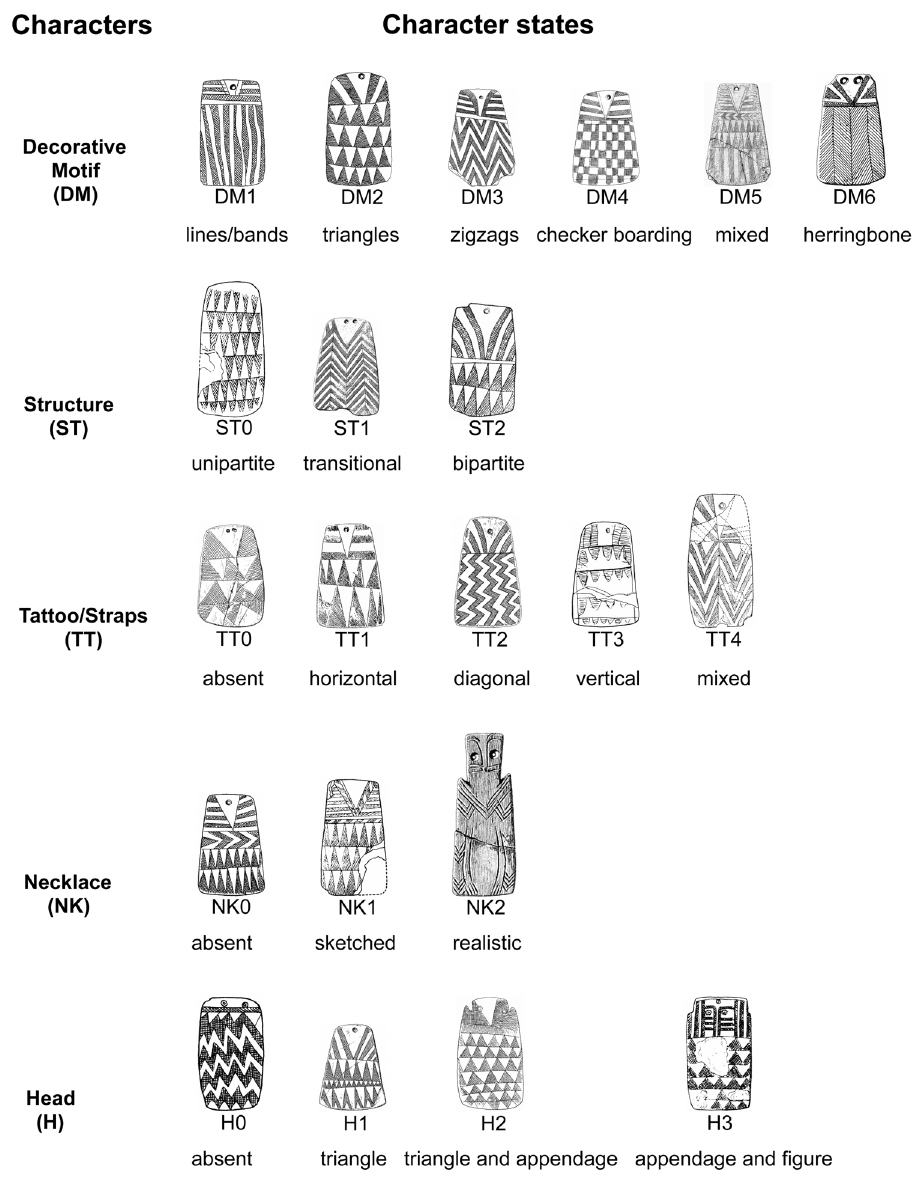
Figure 3. Character states used in the analysis.